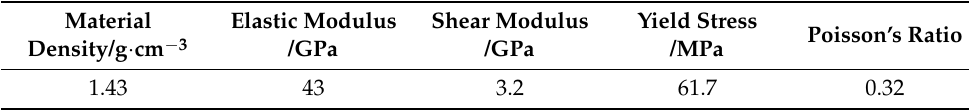
Table 4. Mechanical parameters of the shaped energy